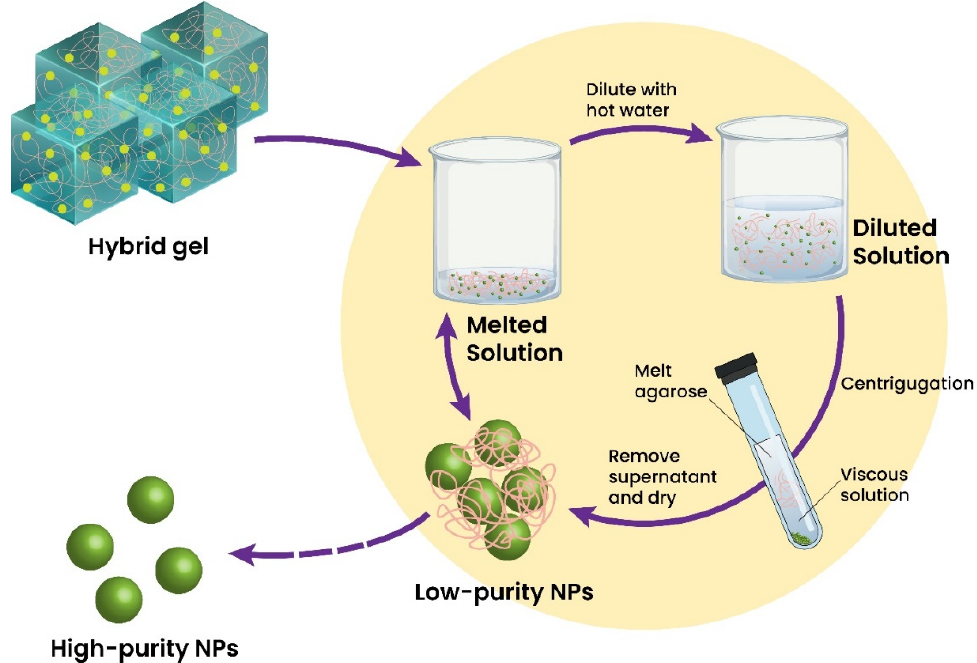
Figure 3. TiO 2 /agarose hybrid gel and the recycling and recovery of TiO 2 nanoparticles through heating and separation techniques. Adapted with permission from Ref. [201]. ©2017, Royal Society heating and separation techniques. Adapted with permission from Ref. [201] . ©2017, Royal Society of Chemistry. of